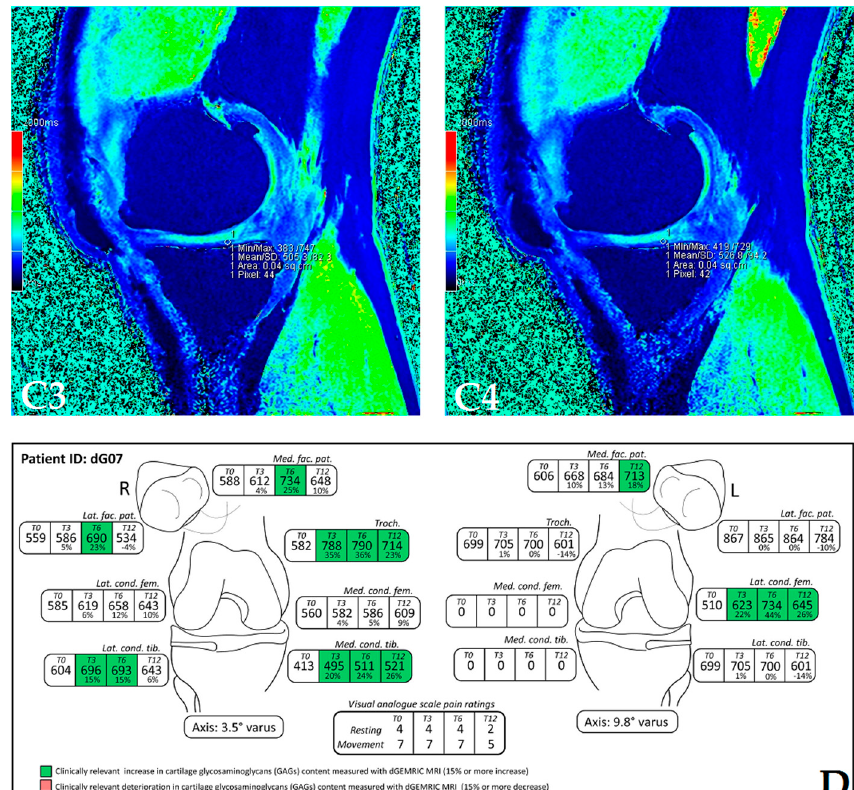
Figure 2. (Patient dG07) Coronal ( A ) and sagittal ( B ) MRI show complete loss of articular cartilage of the medial femoral and tibial condyles (ICRS grade IV chondromalacia), thinning and shallow fissures of the articular cartilage in the lateral femoral and tibial condyles (ICRS grade IV chondromalacia), edge osteophytes and joint effusion. The MRI with the dGEMRIC index values at four-time points (T0: baseline; T3: three months after autologous and microfragmented adipose tissue injection; T6: six months after autologous and microfragmented adipose tissue injection; T12: 12 months after autologous and microfragmented adipose tissue injection) ( C1–C4 ). The scheme of the dGEMRIC index with different joint facets throughout the study period at T0, T3, T6 and T12 combined with VAS scale ratings in T0, T3, T6, T12 ( D ).